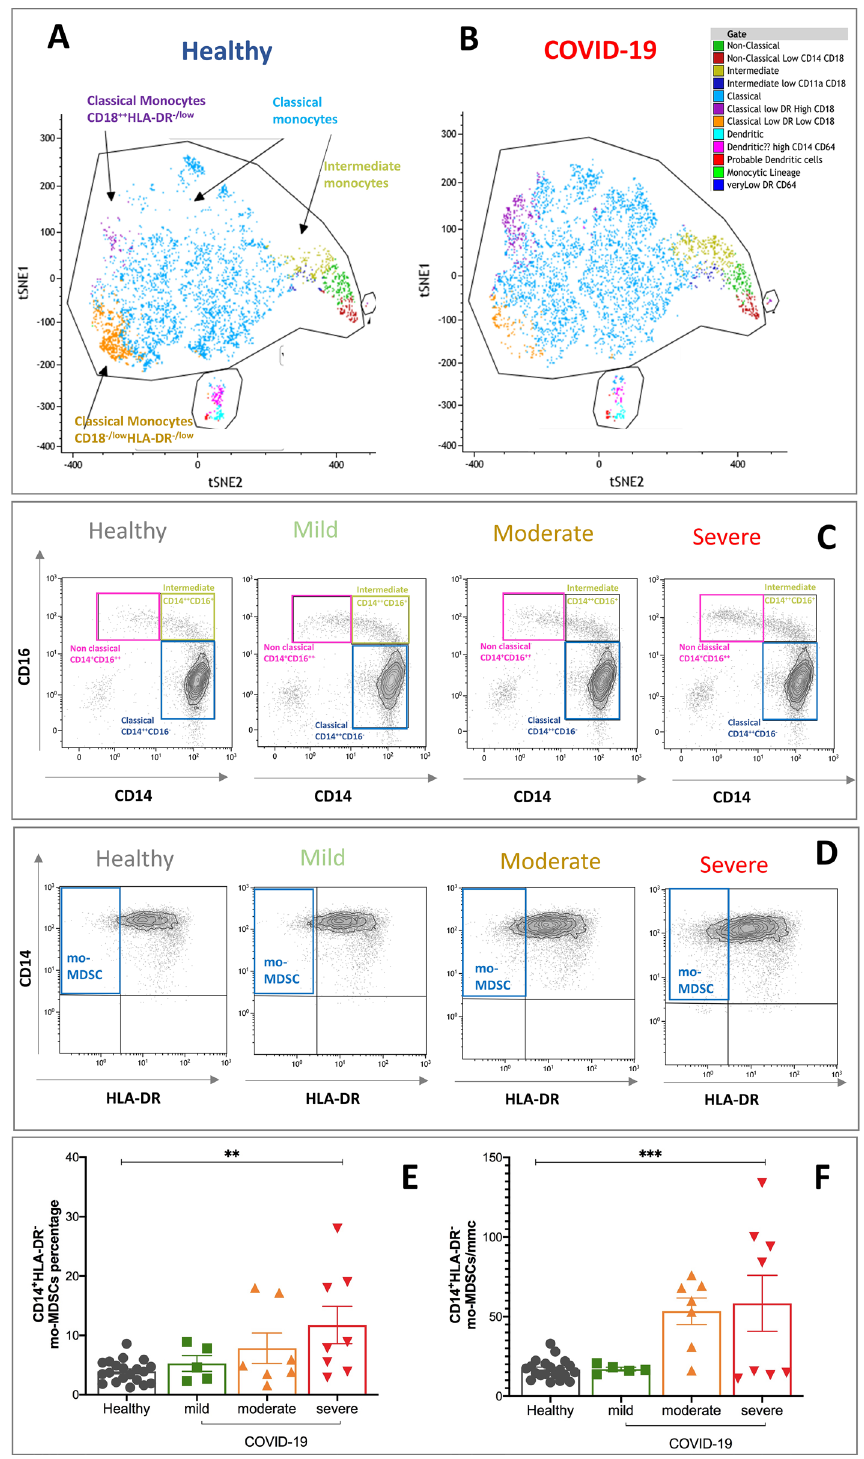
Figure 4. Dysregulation of myeloid cells in peripheral blood of COVID-19 patients. Application of T-distributed stochastic neighbor embedding (t-SNE). Clusters were named based on the cluster-specific antigen expression patterns in healthy subjects (A) and COVID-19 patients (B) . Example of gating strategy based on CD14 and CD16 expression in circulating monocytes to identify non-classical, intermediate and classical monocytes in healthy and COVID-19 patients (C) . Detection of percentage and absolute counts of monocyte-like myeloid derived suppressor cells identified as CD14 + -HLA-DR - monocytes (D) . Color code: grey, healthy subjects; green, mild COVID-19; orange, moderate COVID-10, red, severe COVID-19. COVID-19 severity was defined according to qCSI, based on respiratory rate, pulse oximetry and oxygen flow rate. Stars denote significance according to ANOVA test among the three COVID groups (mild, moderate, severe), *p < 0.005, **p <